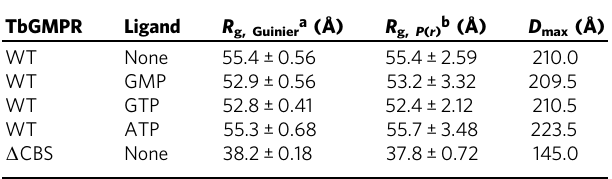
a R g values calculated from Guinier plots. b R g values calculated from P ( r ) pro fi le